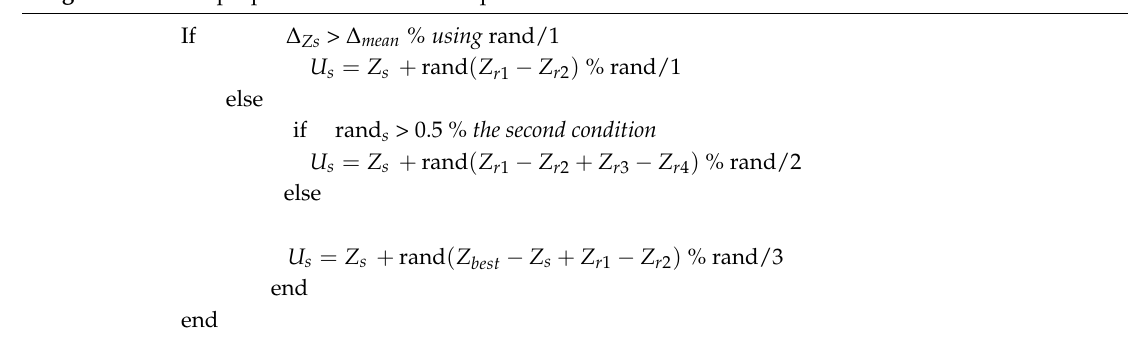
Algorithm 1: The proposed mutation